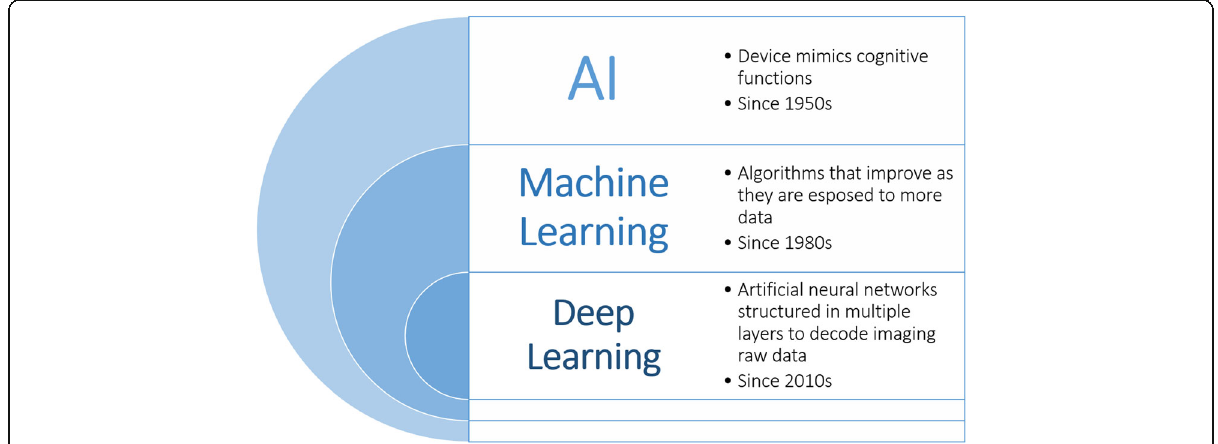
Fig. 1 Deep learning as a subset of machine learning methods, which represent a branch of the existing artificial intelligence techniques. Machine learning techniques have been extensively applied since the 1980s. Deep learning has been applied since the 2010s due to the advancement of computational